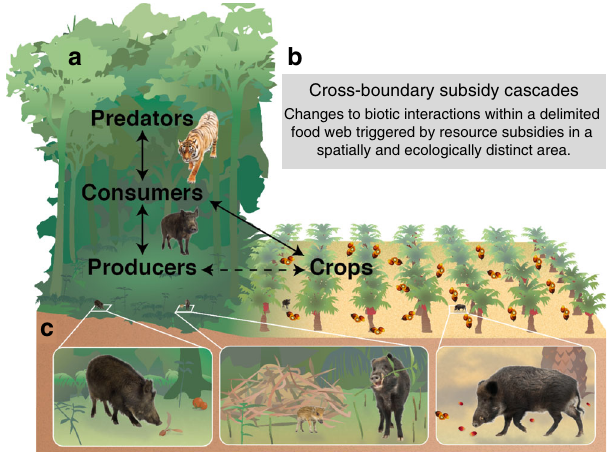
Fig. 1 Cross-border subsidy cascades from farmland to rainforests. a Scene depicting resource subsidies from oil palm plantations consumed by forest wildlife in Malaysia and the secondary trophic effects within forest food webs. Solid lines show direct effects, dotted line shows the indirect effect. This study focuses on the indirect link between native forest trees and cultivated oil palm, mediated by wild boars traveling between habitats. b De fi nition of a cross-boundary subsidy cascade. c Scenes depicting crop- raiding wild boar eating forest tree seeds (left), breaking saplings to make nests (middle), and eating oil palm fruits